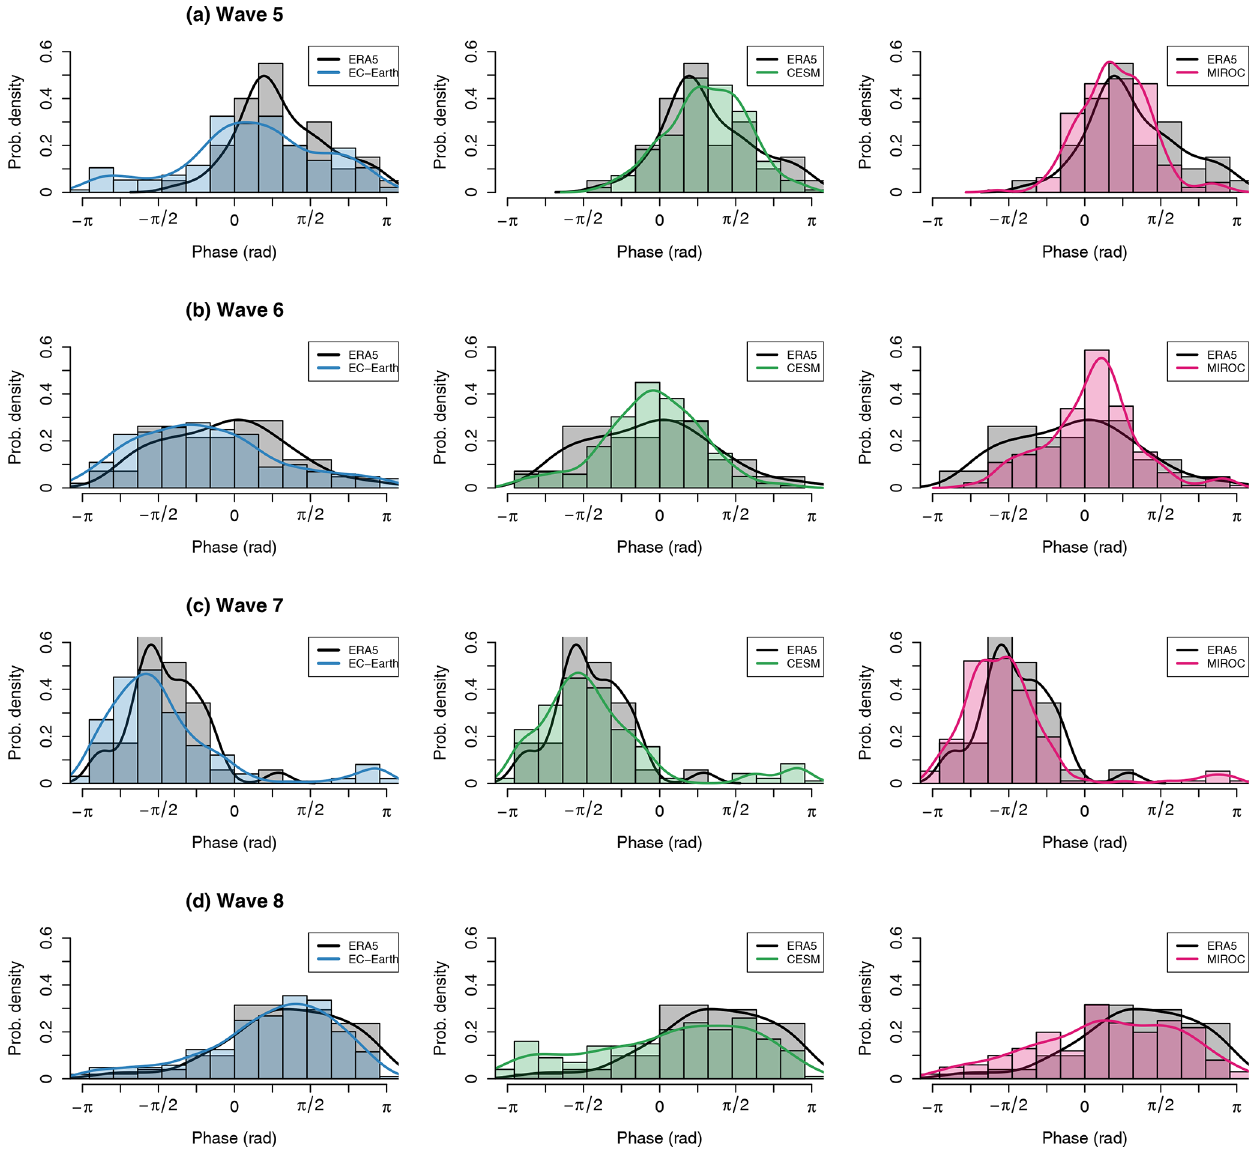
Figure B2. Same as Fig. 2 but with histogram